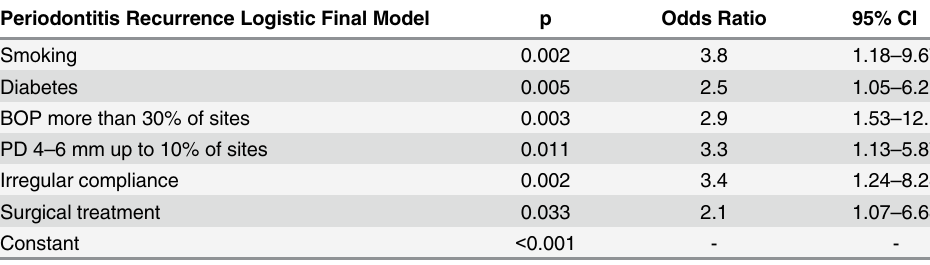
Table 4. Final logistic regression model for the recurrence of periodontitis at final